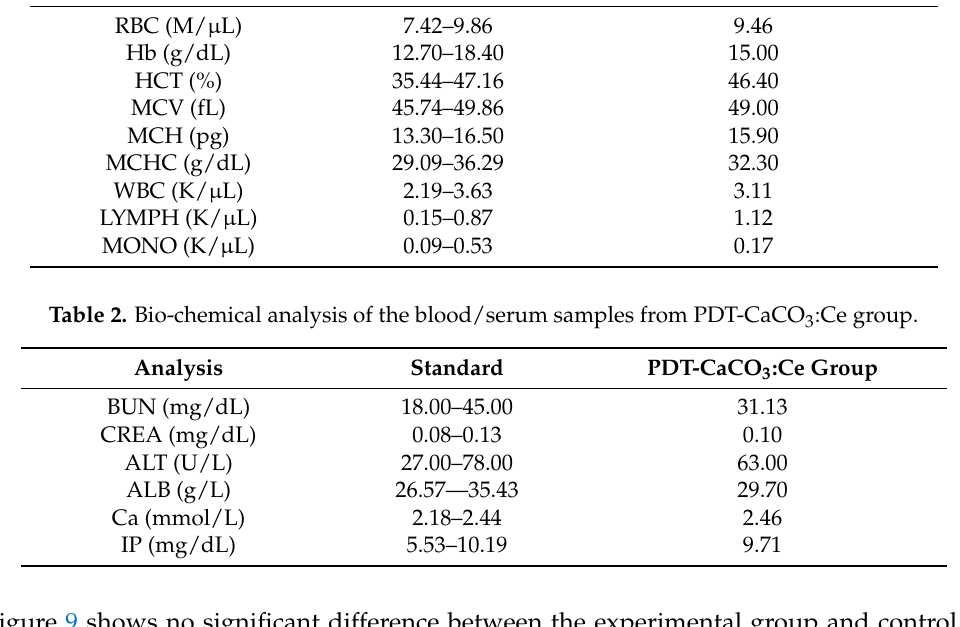
Table 1. Bio-chemical analysis of blood samples from PDT-CaCO 3 :Ce group. Figure 8. The tumor size ( a ) and body weight ( b ) in BALB/c nude mice injected with CaCO 3 :Ce and subjected to X-ray irradiation (t-test, mean ± SD, n = 4, **: p -value < 0.01).